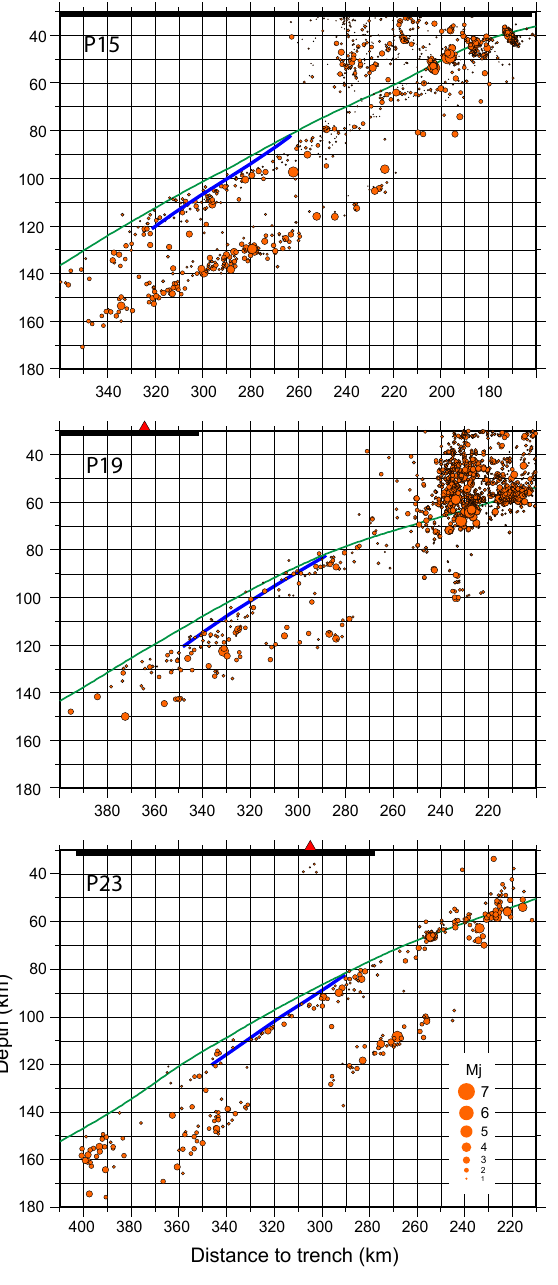
Fig. 6. Same as Fig. 5, but now for the cross sections in western Hokkaido above the juncture between the Tohoku and Hokkaido subduction